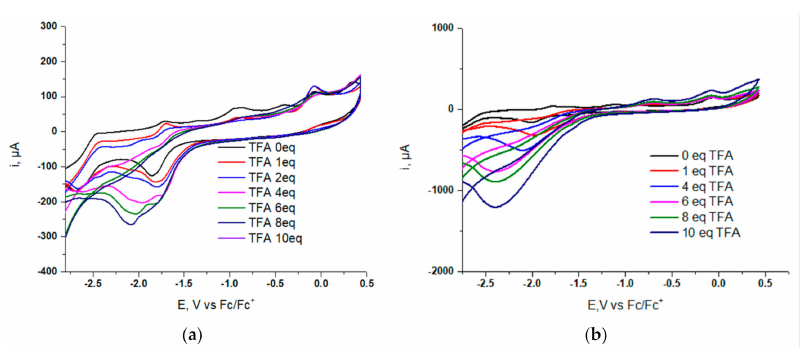
Figure 5. Electrocatalytic hydrogen production of the complex ( a ) 1 (10 − 3 M), ( b ) 2 (10 − 3 M) in DMF with TFA as a proton donor, 0.1 M n-Bu 4 NPF 6 , a glassy carbon as a working electrode, an Ag/AgCl as a reference electrode and a Pt wire as a counter electrode. The scan rate was 100 mV/s under